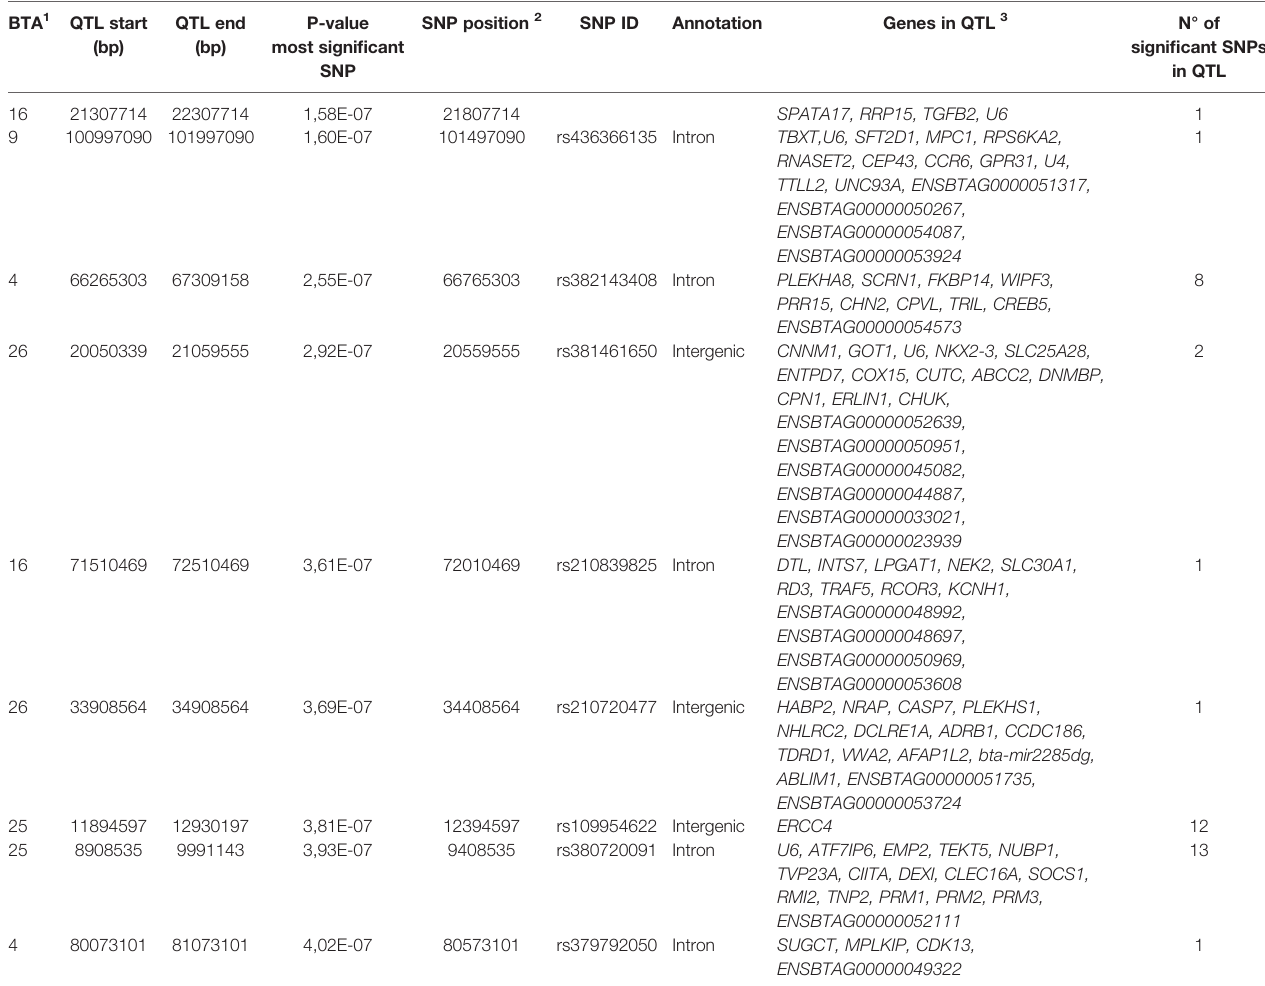
TABLE 3 | QTLs surpassing the signi fi cance threshold ( P < 5 × 10 -7 ) for evidence of an association with